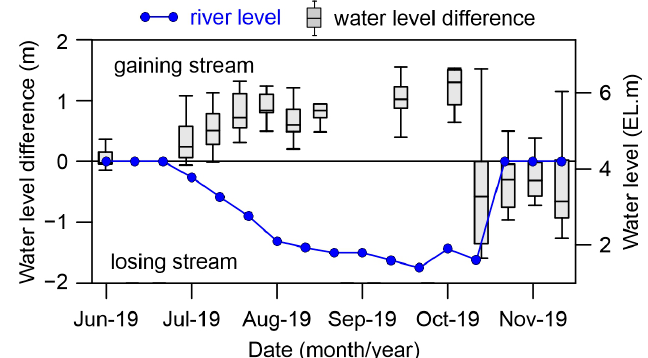
Figure 5. Change in groundwater–surface water interaction (box-whisker plots) with river level variation (points) during weir operation. variation (points) during weir operation.